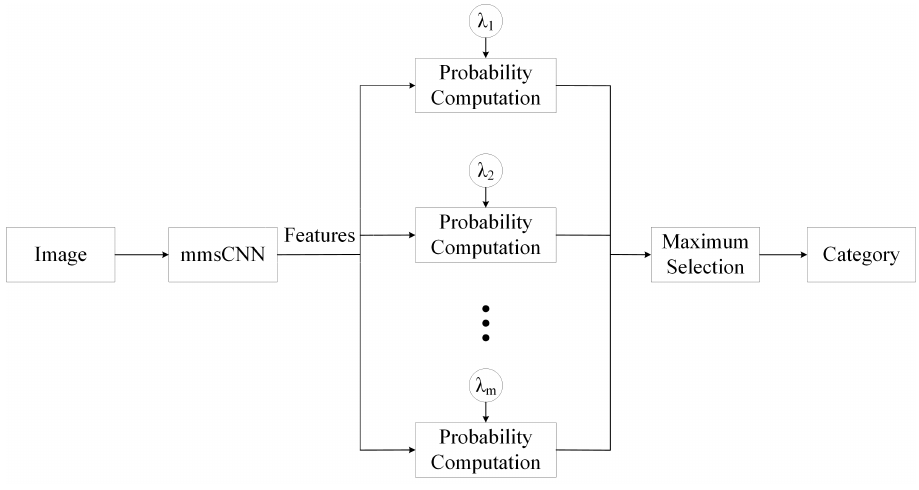
Figure 8. The recognition process of the HMM